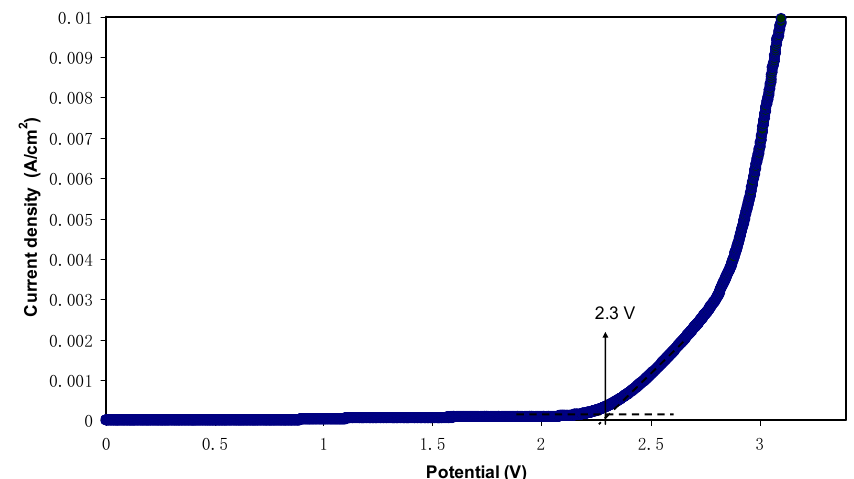
Figure 9. LSV plot for the highest conducting chitosan-dextran-LiClO 4 (CSDPB4) sample.